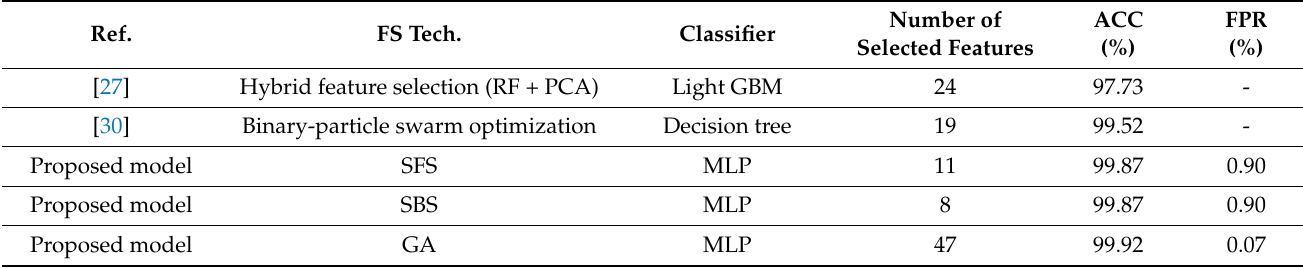
Table 14. Performance comparison with recent methods in CIC-IDS-2018.